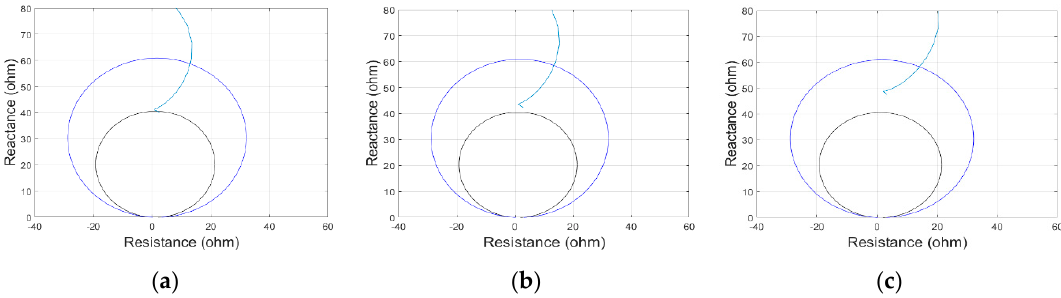
Figure 8. Fault impedance loci for a fault at 70km with time synchronization error on the B-phase